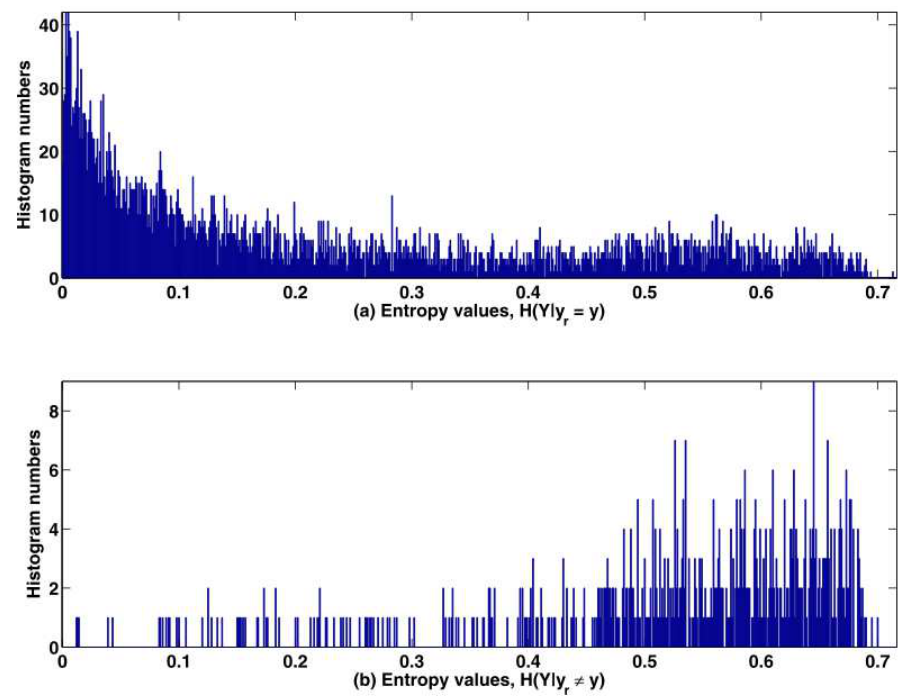
Figure 9. Distributions of entropies, ( a ) H ( Y | y r = y ) and ( b ) H ( Y | y r (cid:54) = y )